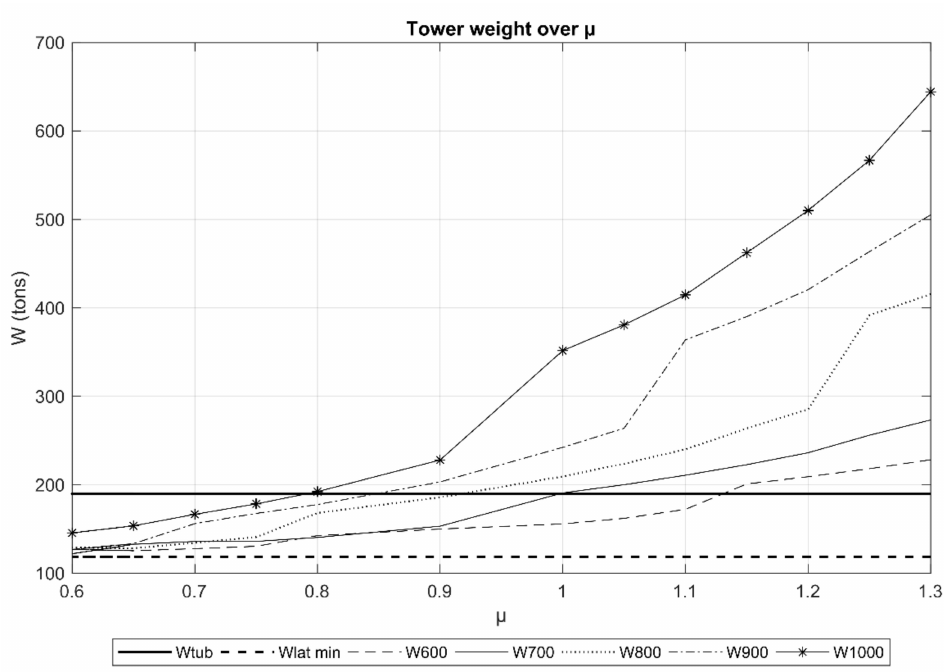
Figure 16. Total weight of tower cases in correlation with µ and Btop for the 105 m